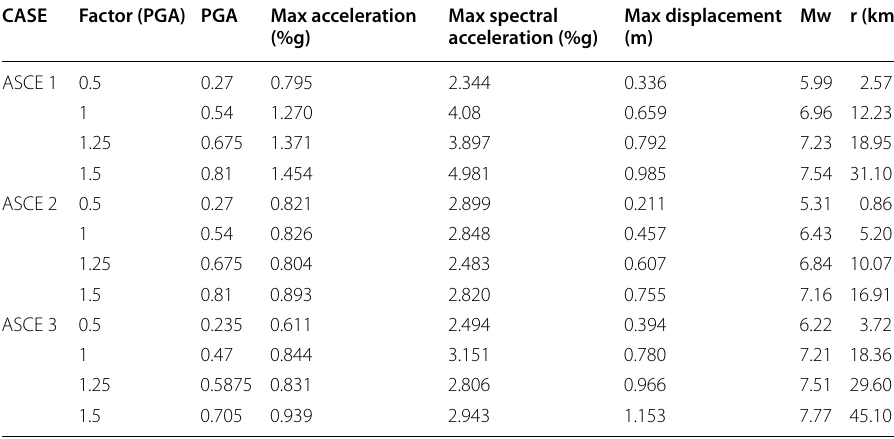
Table 3 Maximum response values and displacement‑based methodology